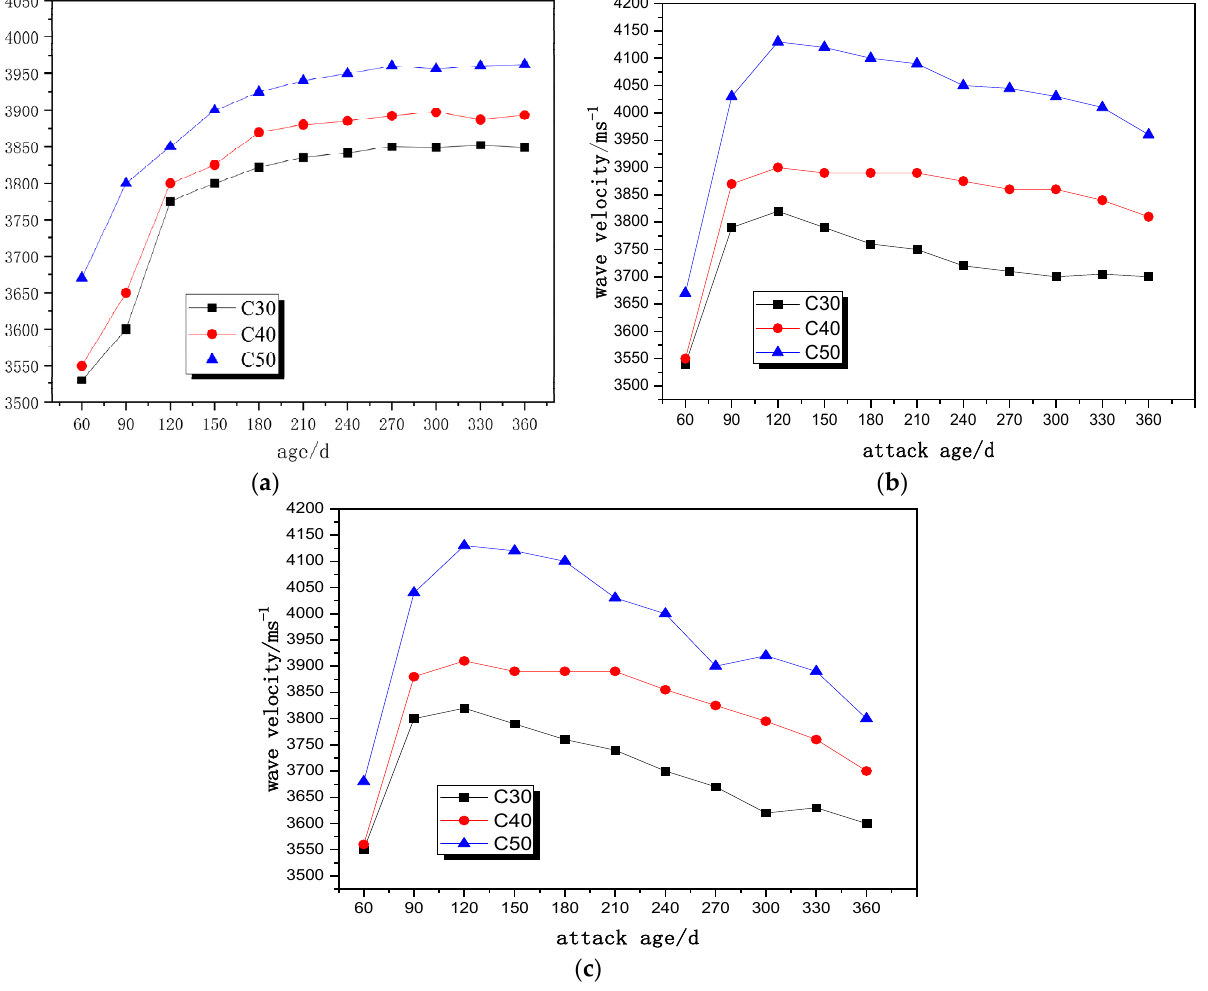
Figure 3. Wave velocity variation diagram of concrete at maximum stress level 0.5 and minimum stress level 0.2. ( a ) Sulfate concentration 0%; ( b ) sulfate concentration 5%; ( c ) sulfate concentration 10%.